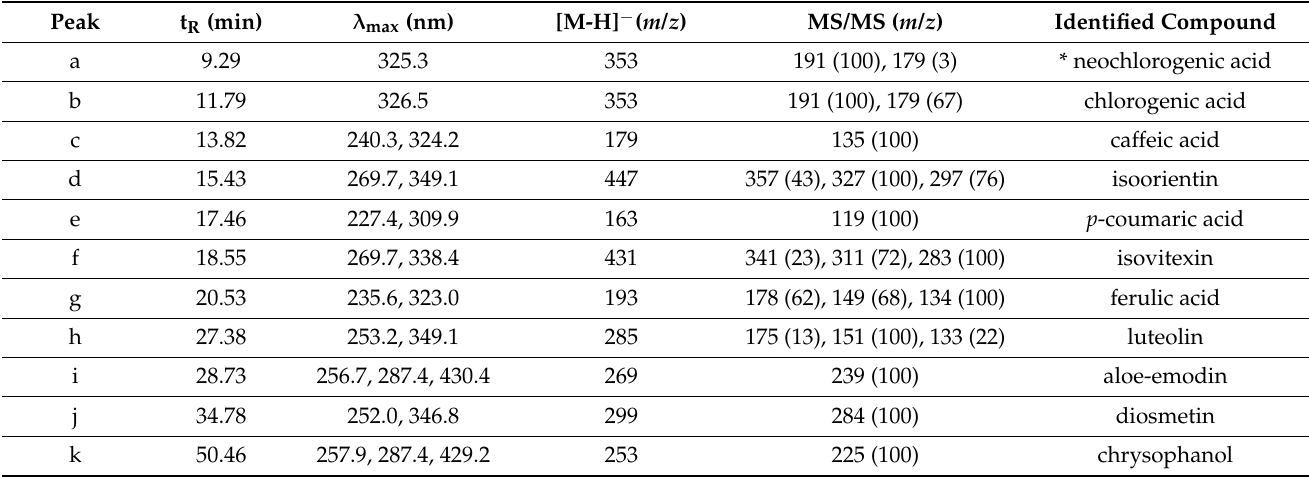
Table 1. Characterization of the peaks of interest obtained from A. bento-rainhae and A. macrocarpus leaf crude extracts and their subsequent L-L partitions.